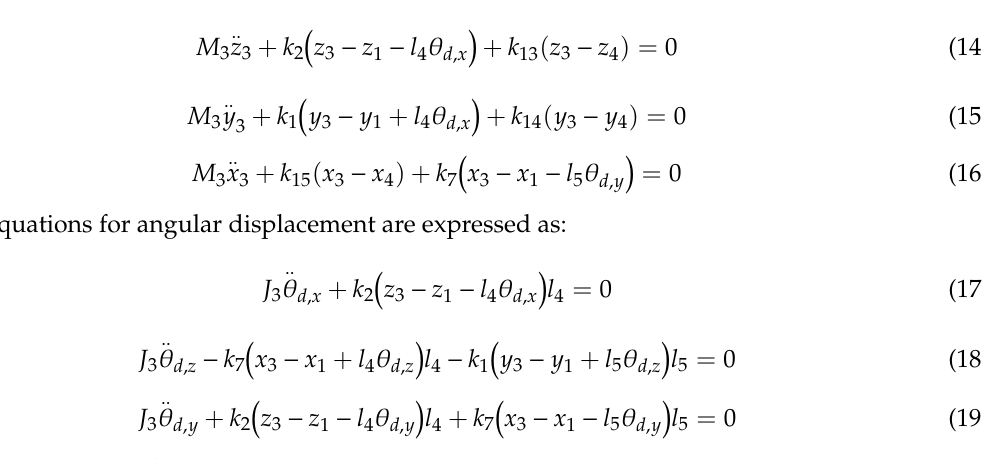
Figure 5. Free-body diagrams of the housing. In the proposed method, forcing conditions were applied to the housing in the vertical ( z -axis) direction. The governing equations for 𝑀 (cid:2872) are as follows: